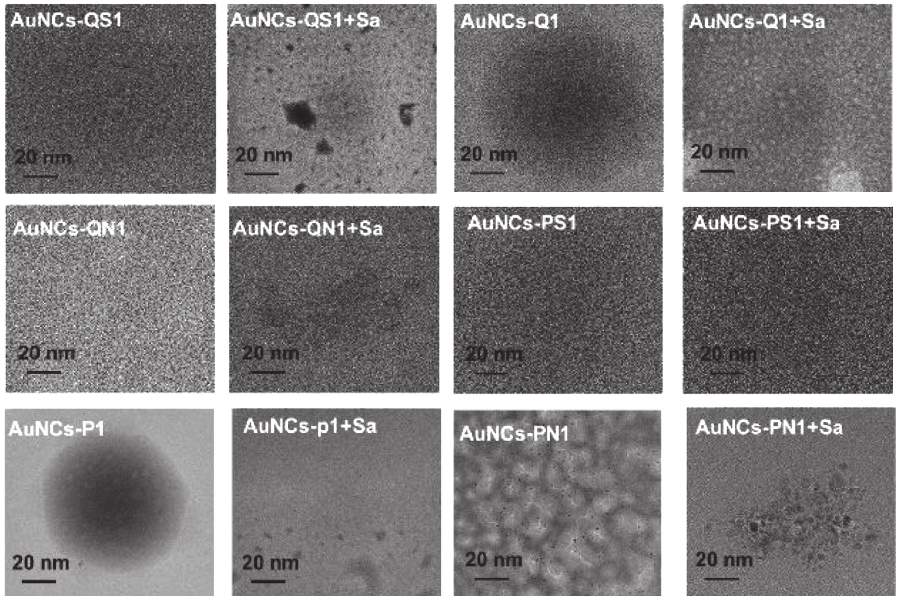
Figure 3: TEM of AuNCs in the presence of the aptamers and CA125.